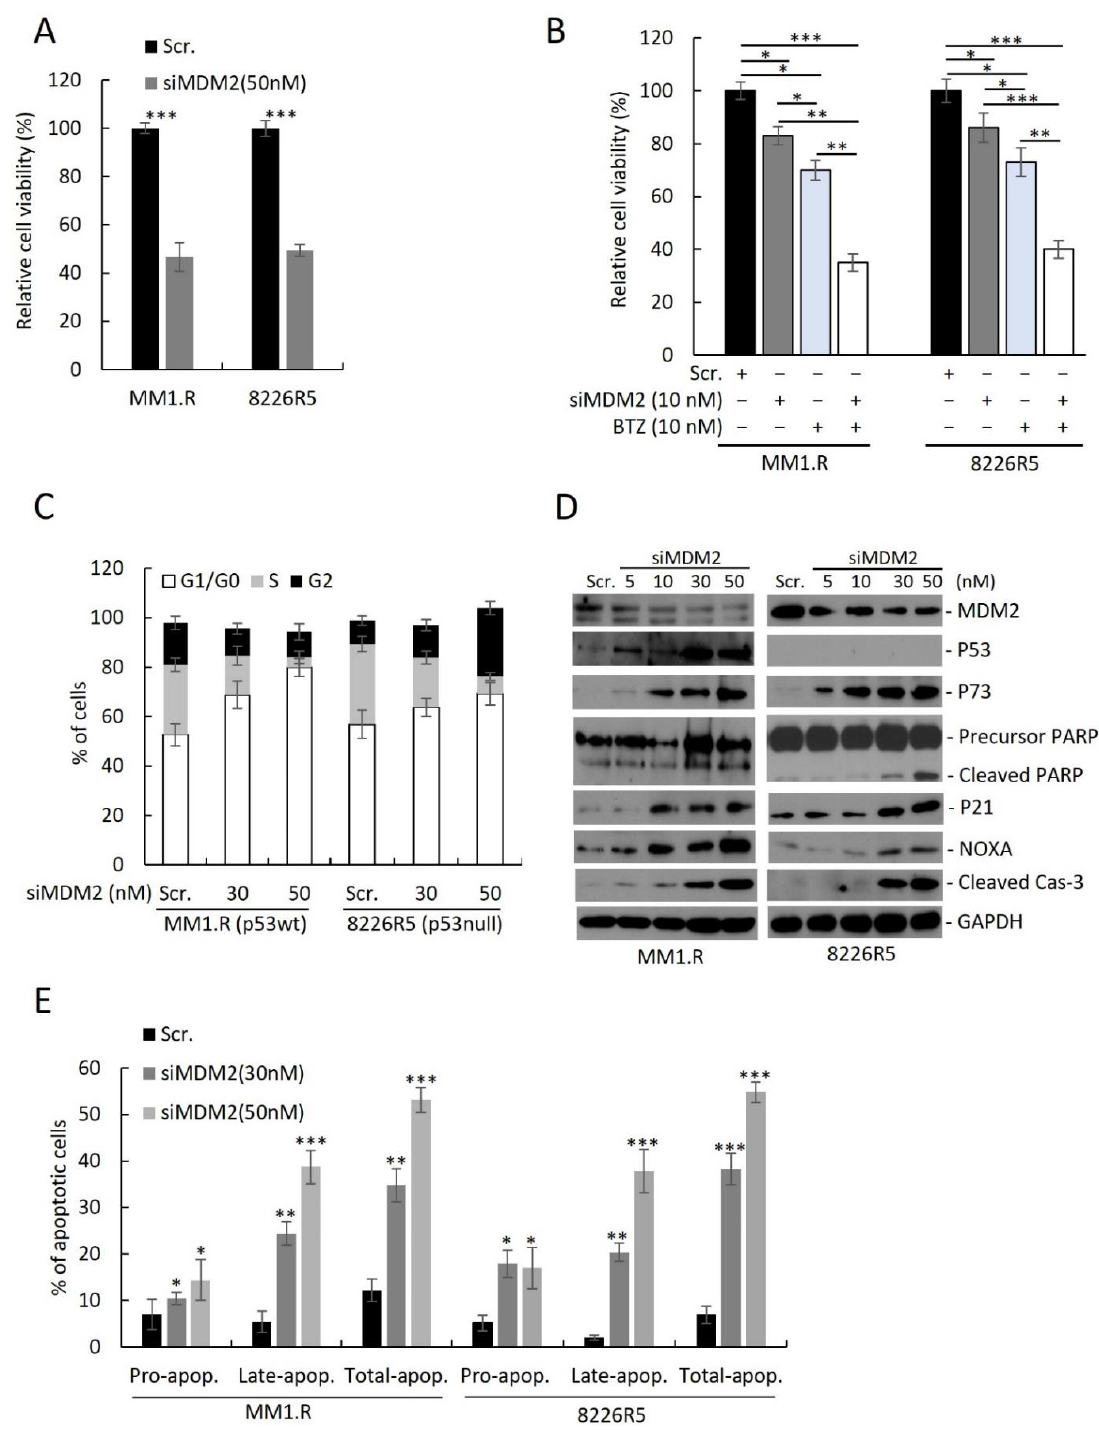
Figure 2. Knockdown of MDM2 induces growth inhibition, apoptosis and cell cycle arrest in drug resistant MM cells. ( A ) Cell viability of MM1.R and 8226R5 cells after 48 h transfection with scrambled siRNA (Scr) or siMDM2 (50 nM). ( B ) Cell viability of MM1.R and 8226R5 cells after 24 h transfection with scrambled siRNA (Scr) or 10 nM siMDM2 followed by 24 h treatment with 10 nM BTZ or drug vehicle. Results are presented as mean ± SD of three independent experiments. ( C ) Bar plots indicate the distribution of cells in each cell cycle phase for MM1.R (p53wt) and 8226R5 (p53null) after 48 h transfection with scrambled siRNA (Scr) or different concentrations of siMDM2, as indicated. Results are presented as mean ± SD of three independent experiments. ( D ) Western blot of cell lysates from MM1.R and 8226R5 cells after 48 h transfection with scrambled siRNA (Scr) or siMDM2. The